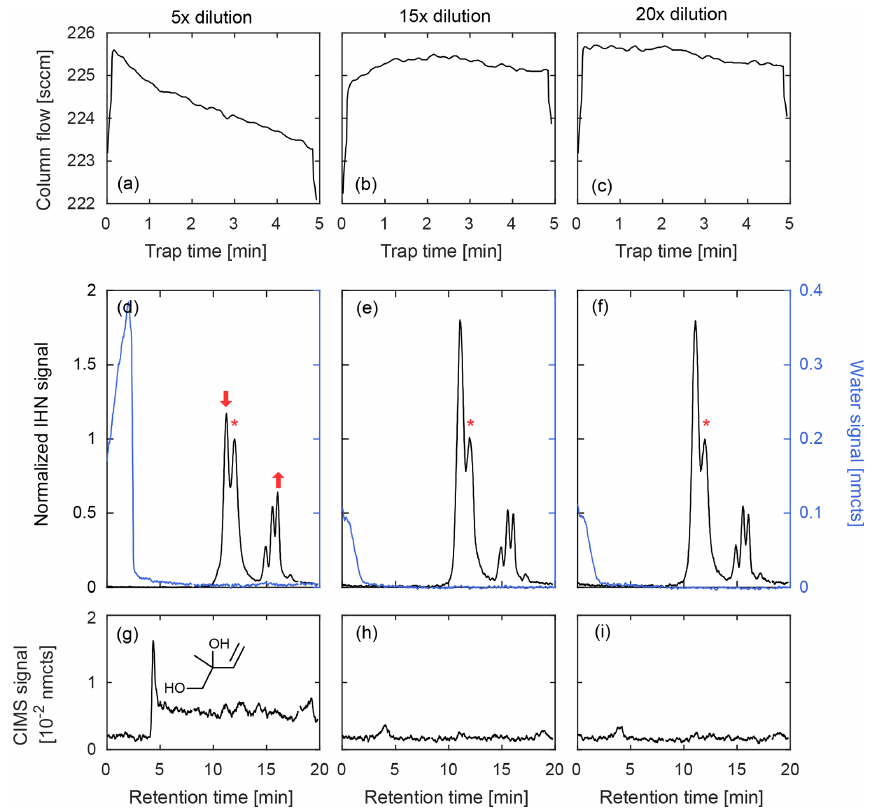
Figure 7. Comparison of GC column flow (a–c) and three chromatograms (d–f) of IHN ( m/z 232, black) and water ( m/z 104, blue) at three different dilutions from a high-RH chamber experiment. The beginning of a chromatogram is marked when the temperature program initiates. When water is trapped during the lowest dilution (5 × ), column flow decreases (indicating an ice blockage) and the isomer distribution of IHN is dramatically altered as noted by a loss in the first peak (1,2-IHN) and increase in the last peak ( E 1,4-IHN). These peak changes are marked by arrows and described relative to 4,3-IHN ( ∗ ). The 1,2-isoprene diol ( m/z 187, g ), an expected product of 1,2-IHN hydrolysis, is also observed in this scenario. However, when the sample is sufficiently diluted prior to trapping, the water signal quickly falls to background levels and isomer distribution is preserved with minimal diol formation. Column flow also remains relatively stable throughout the trapping period when minimal water is